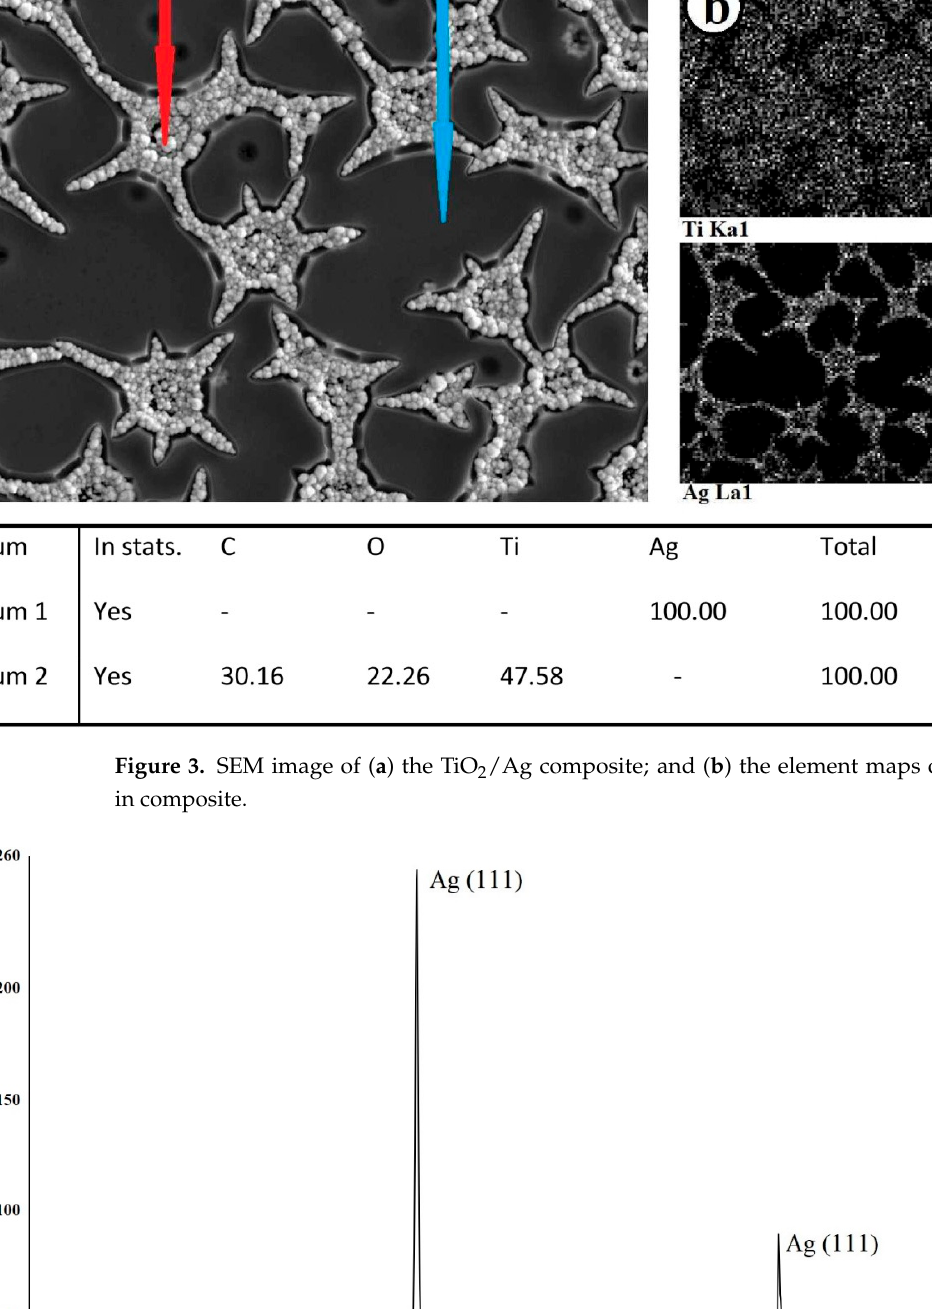
Figure 5. SEM image and element maps of Ti, Ag, Ca, P for TiO 2 /Ag/HAp composite. Micrographs and element maps show that a high level of localization of calcium and phosphorus has been achieved, and the deposited HAp repeats the geometry of the TiO 2 /Ag template. Microscopy of the sample section showed that the resulting coating had a thickness of several hundred nanometers, and the HAp particles themselves rise above the surface of titanium, creating a micron roughness of the coating (Figure 6). This coating is also chemically close to the mineral composition of bone, which is important for bone implantation.